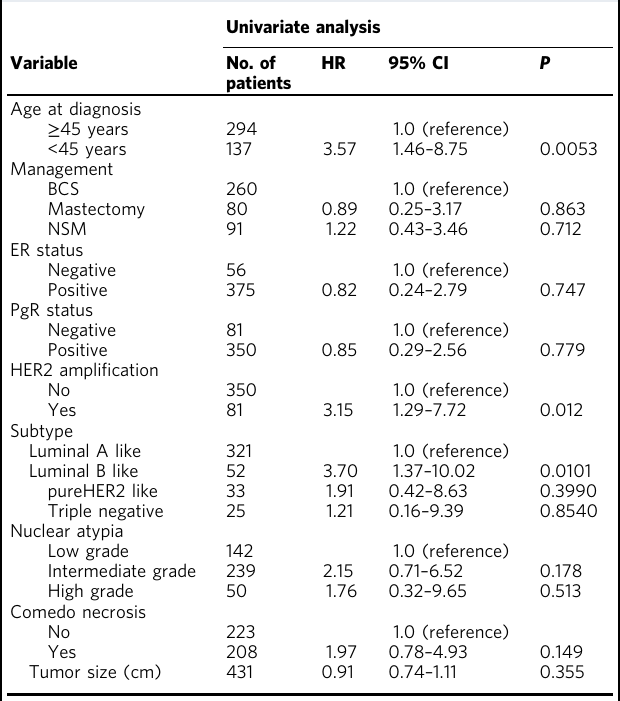
Table 1 Clinicopathological factors associated with prognosis according to Cox proportional hazard